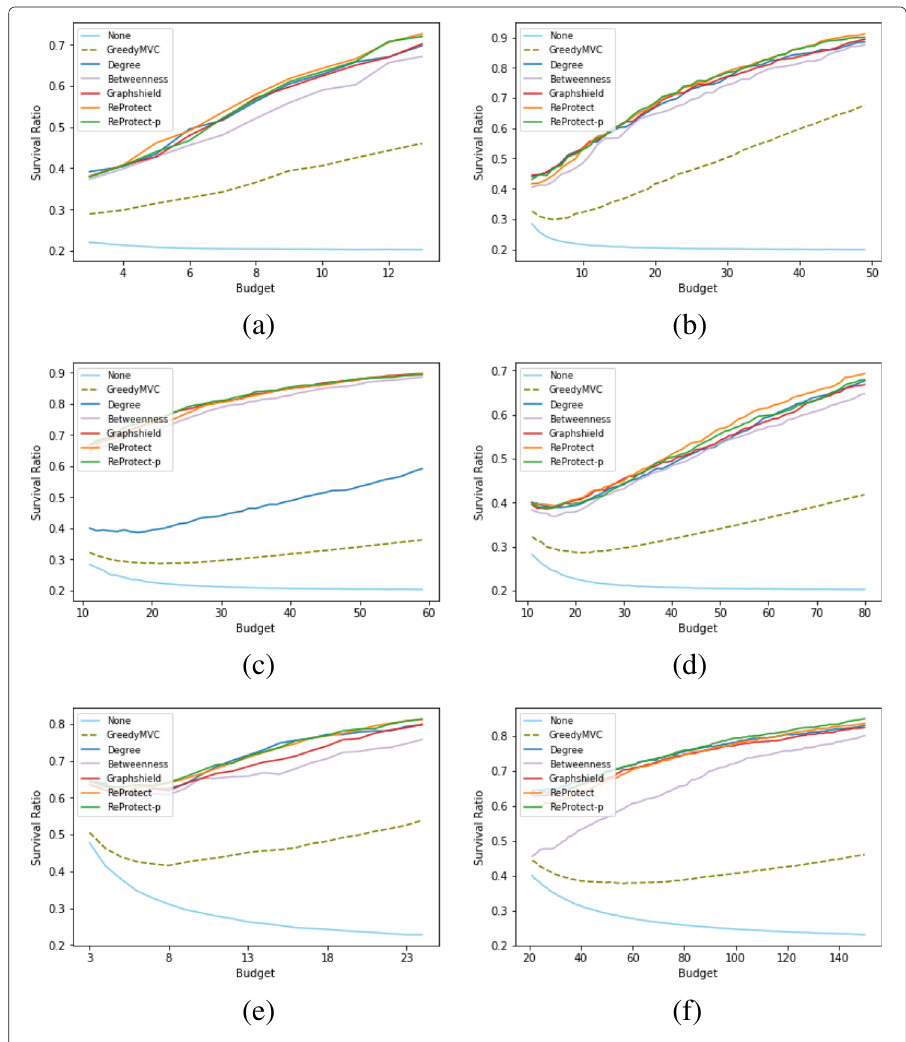
Fig. 6 Effectiveness evaluation on SIS epidemic model. Both of our proposed methods (green and orange colored lines) outperform the other competitors. Higher is better. a Hospital. b Hypertext 2009.